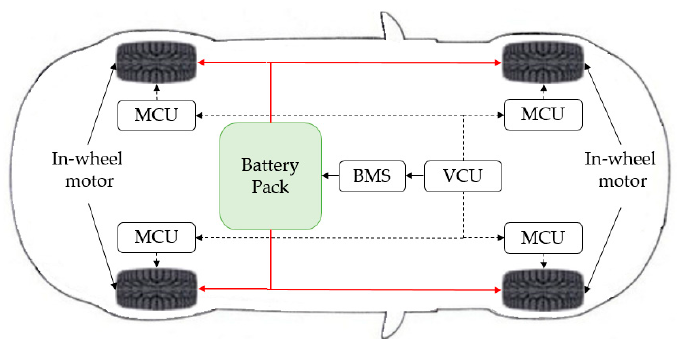
Figure 1. The architecture of the powertrain structure of a typical Four-wheel-independently-actuated Electric Vehicle (FWIA EV). MCU: Motor Control Unit; VCU: Vehicle Control Unit; BMS: Battery Management